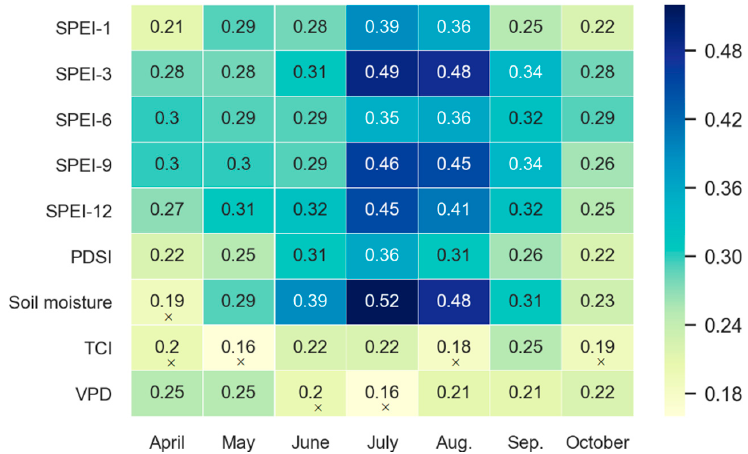
Figure 8. Spatiotemporal distribution of the correlation coefficients between SIF and VPD in each month of growing season. Pixels with white color mean non-grassland or missing data.